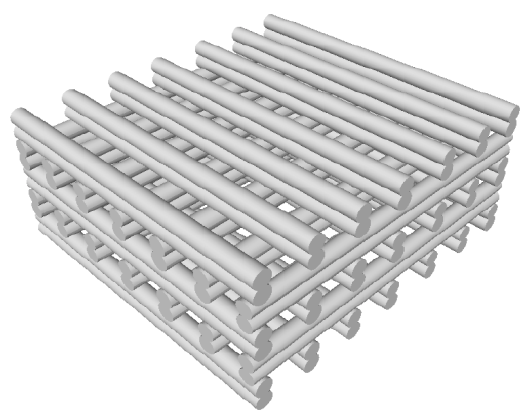
Figure 1. Scheme of a hard-phase (PCL-PEG) scaffold with typical double-strut structure.